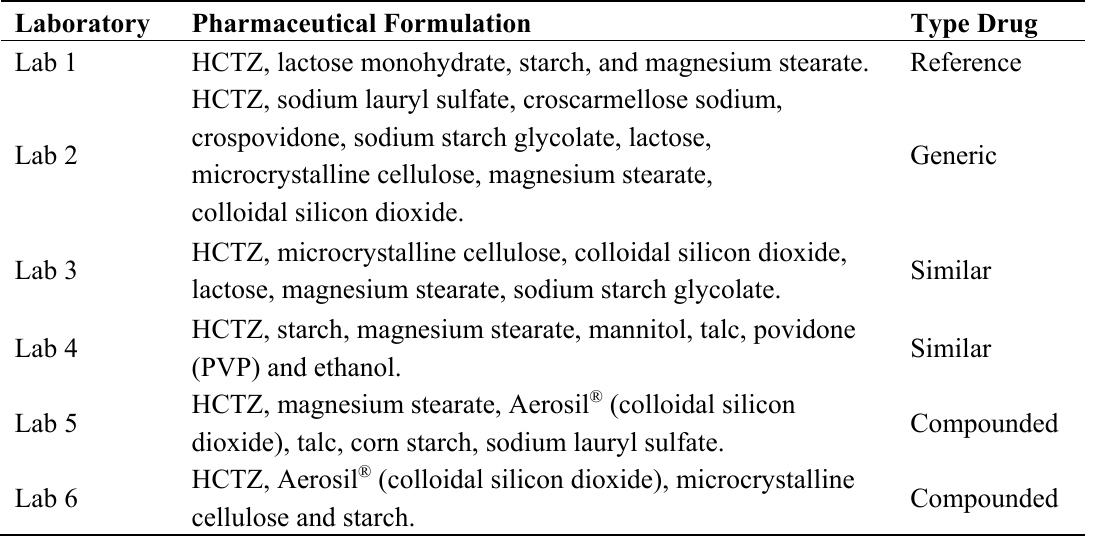
Table 2. Laboratories, pharmaceutical formulation and drug